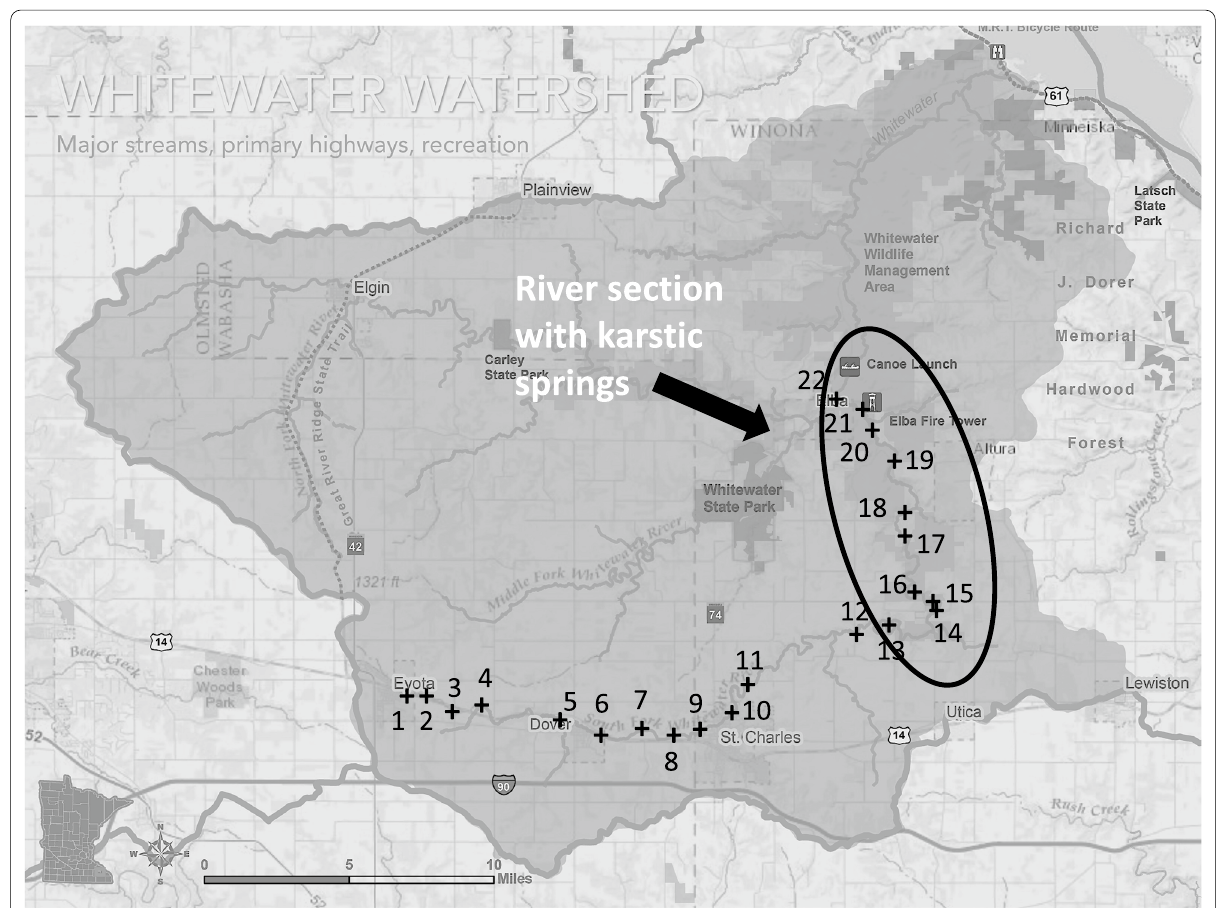
Fig. 1 Map of the Whitewater River watershed in southeastern Minnesota, USA. The Mississippi River is located to the upper right. Sampling sites along the South Fork Whitewater River are numbered from upstream to downstream and are indicated by located near natural